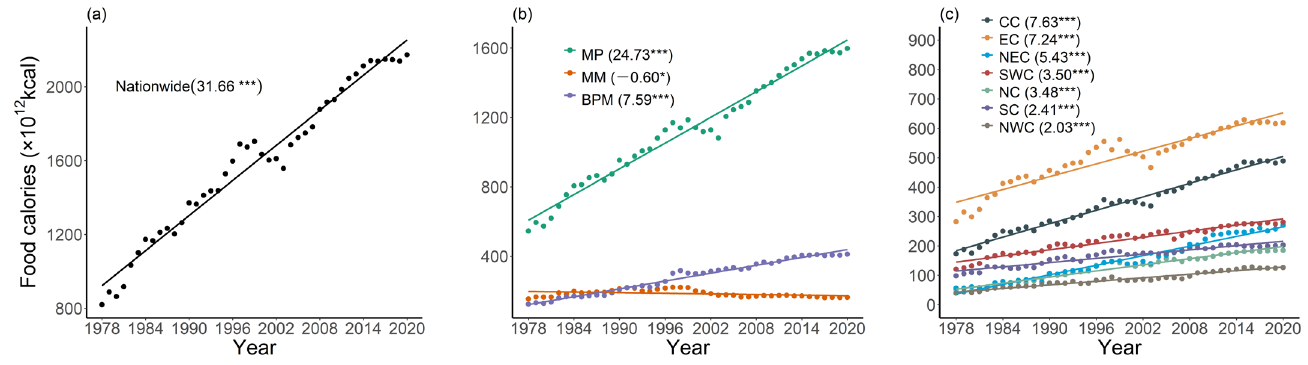
Figure 2. Trends in regional food caloric production from 1978 to 2020: ( a ) nationwide; ( b ) production and marketing sub-regions; ( c ) physical geographic divisions. Note the values in the brackets indicate the growth rate of the food calories (unit: 10 12 kcal/year), with the signs referring to the significance level (***: p < 0.001; *: p < 0.05).